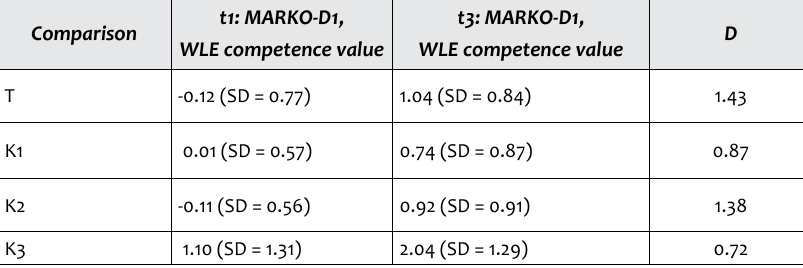
Table 2: Mathematical competence values in MARKO-D1 in the Follow-Up 4 months after end of